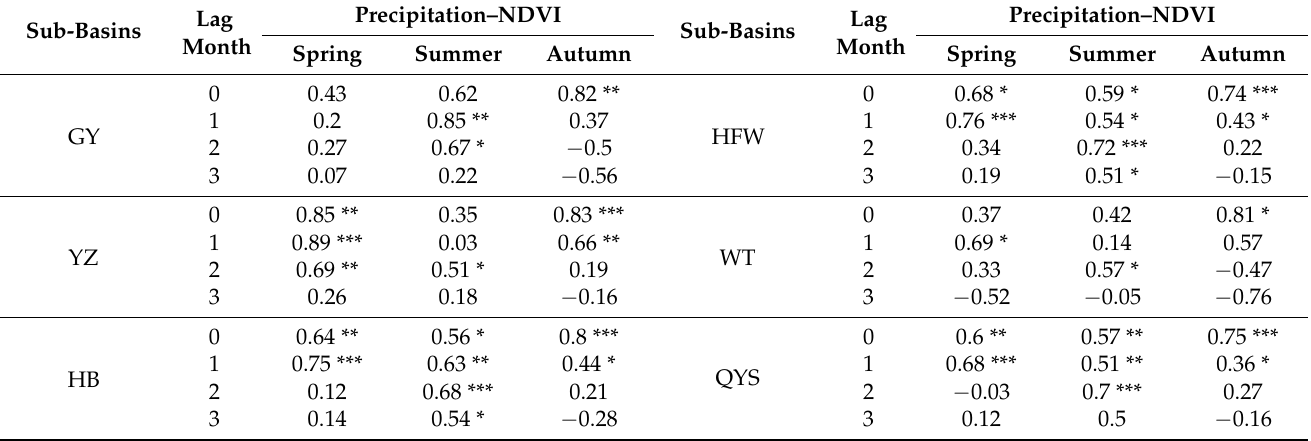
Table 3. The correlation coefficients between precipitation and the